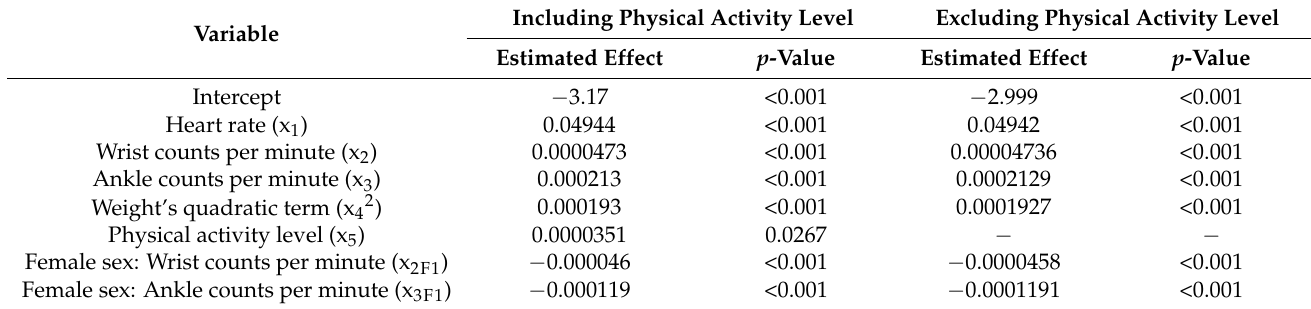
Table 4. Fixed effects of the variables before the